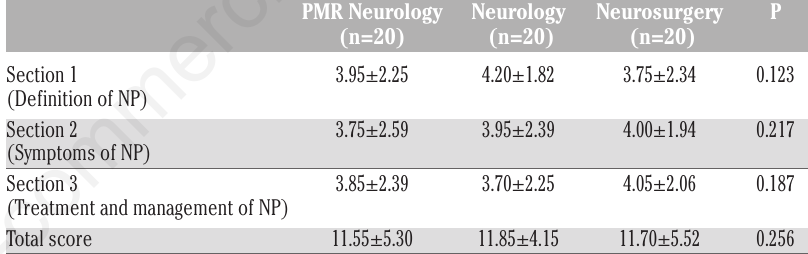
Table 2. Mean scores of questionnaire.